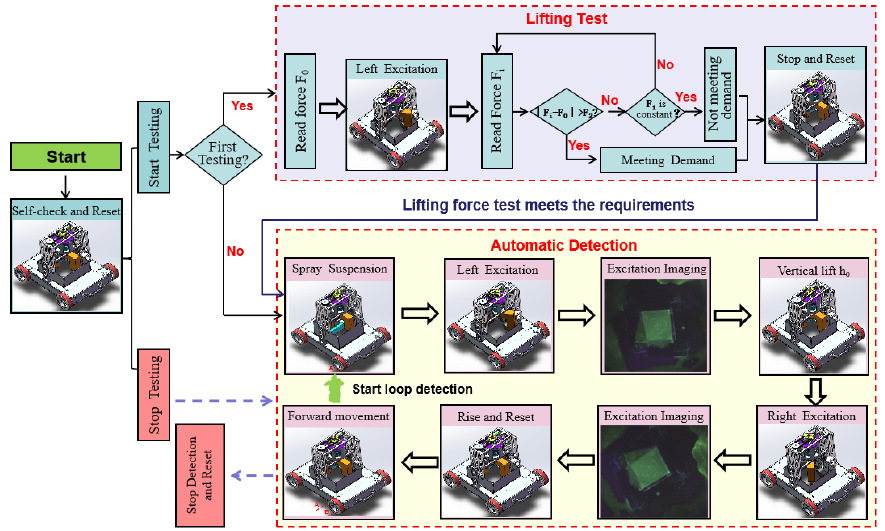
Figure 8. Control system composition.